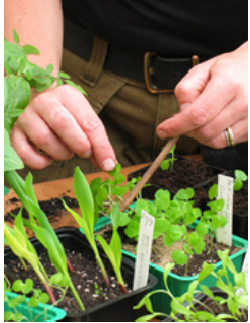
Figure 1. Garden activity (Photo Eva-Lena Larsson).